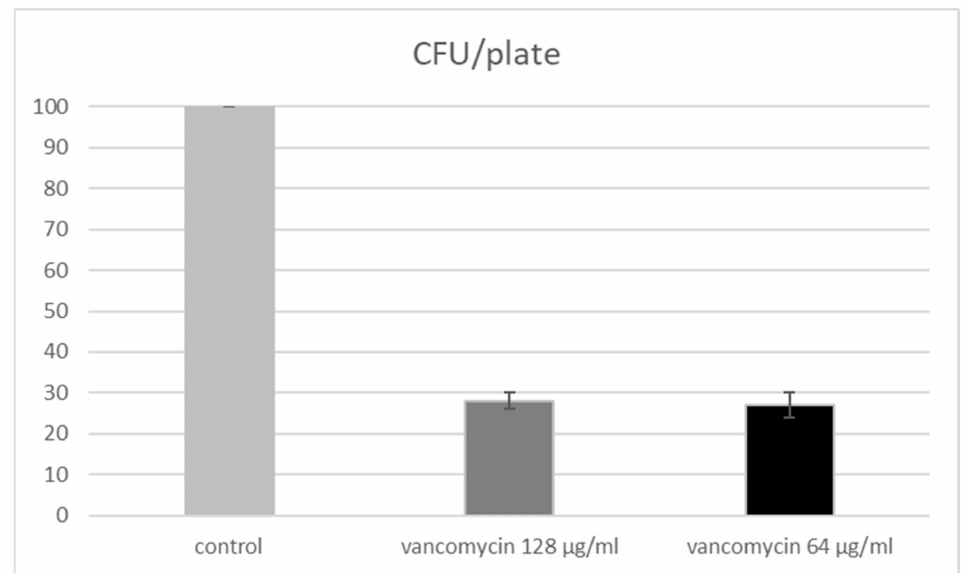
Figure 2. Selection of antibiotic resistance in CFU. To determine whether the isolated CFUs were VRE, mirror MRS plates were made without and with 128 µ g mL − 1 or 64 µ g mL − 1 vancomycin (final concentration). Results are the average of the four independent